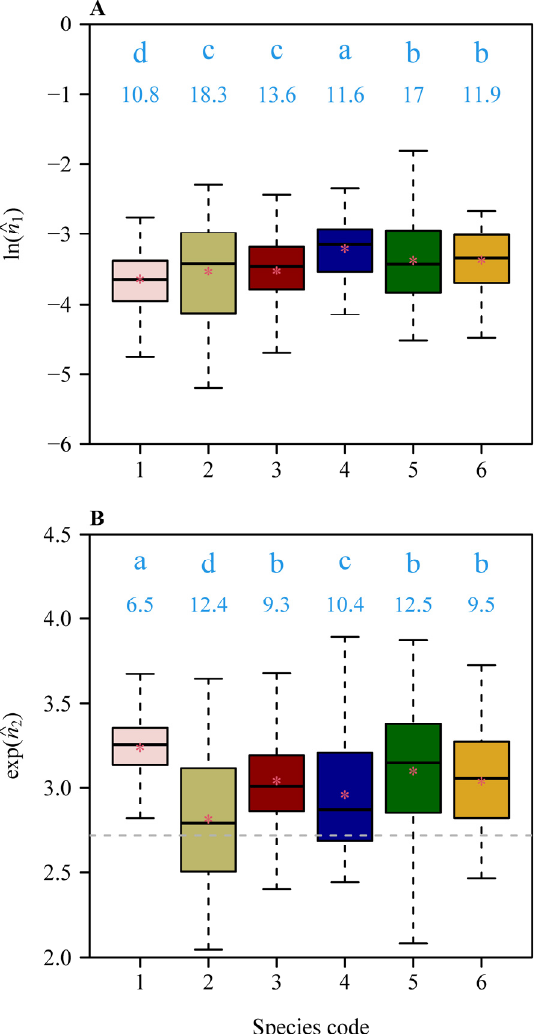
Figure 5. Comparisons of the log-transformed values of the model parameter n 1 ( A ) and the exp- transformed values of the model parameter n 2 ( B ) for the model SGE-2 (Equation (4)) for the six bamboo species (Table 1 for species codes). Different transformations reflect differences in the frequency distributions of the estimated parameter values (right-shewed for n 1 and left-skewed for n 2 ). In each panel, the lowercase letters show the significance of the differences in the estimated values between any two species at the 0.05 significance level. The numeric values at the top of each box provide the coefficients of variation (%). The horizontal solid line represents the median, and the red asterisk the mean. The whiskers provide the 1.5-fold interquartile range or maximum (or minimum) values. In ( B ), the horizontal gray dashed line shows exp(1).